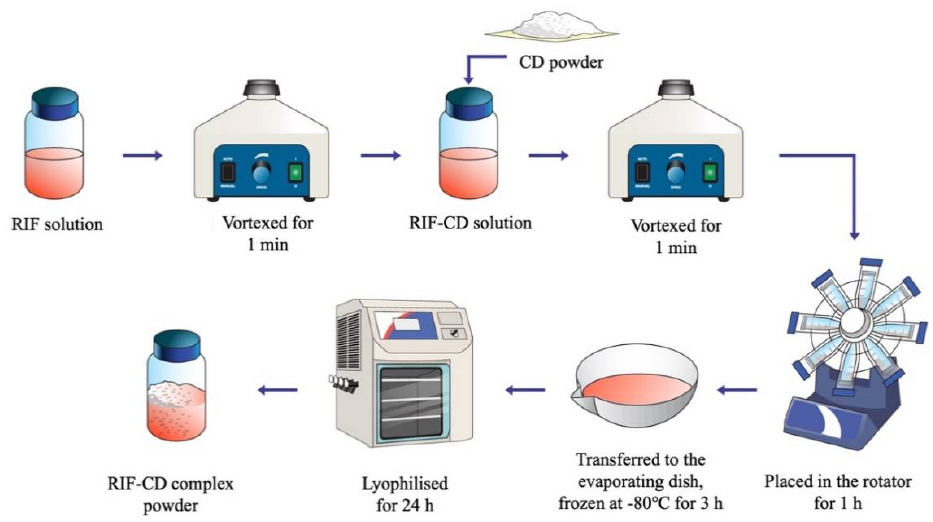
Figure 1. Schematic diagram of RIF-CD complex